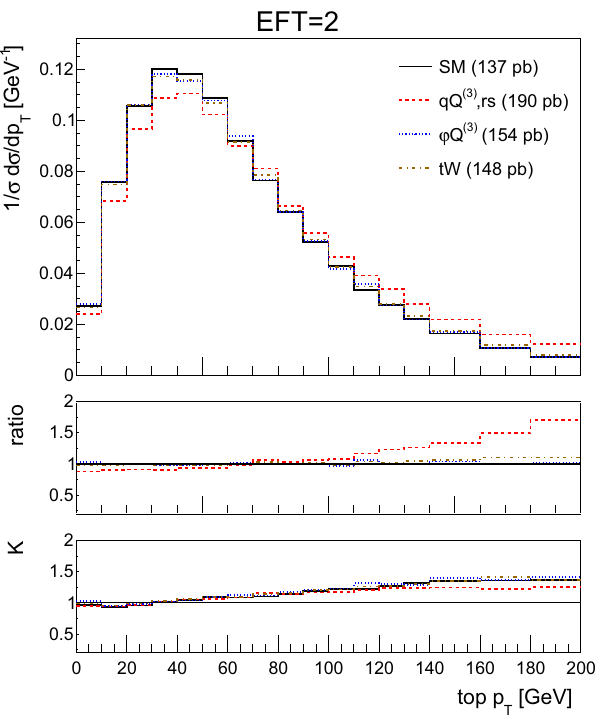
in the left figure the corresponding inclusive cross section from this table. The ratio shown in the first inset is defined as the effect of the operator over the SM, the second inset shows the K -factor